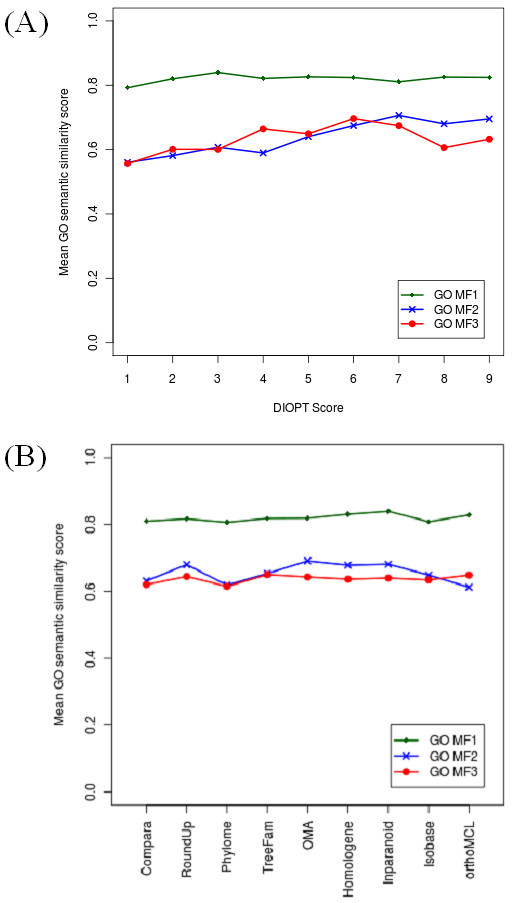
Assessing the correlation of functional relatedness and DIOPT score with gene ontology molecular function (GO MF) annotations. GO MF1, all GO annotations of molecular function. GO MF2, the subset of GO annotations of molecular function supported either by experimental data or author/curator statement. GO MF3, the subset of GO annotation of molecular function supported by experimental data. 2a. Correlation of functional relatedness and DIOPT score with GO MF annotations. 2b. Comparison of the functional relatedness of orthologous genes predicted by individual tools.